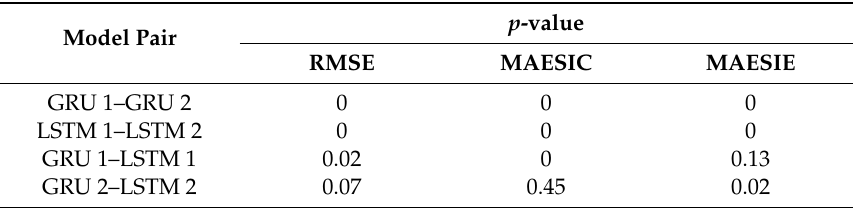
Table 5. T -test results of comparisons between the models.